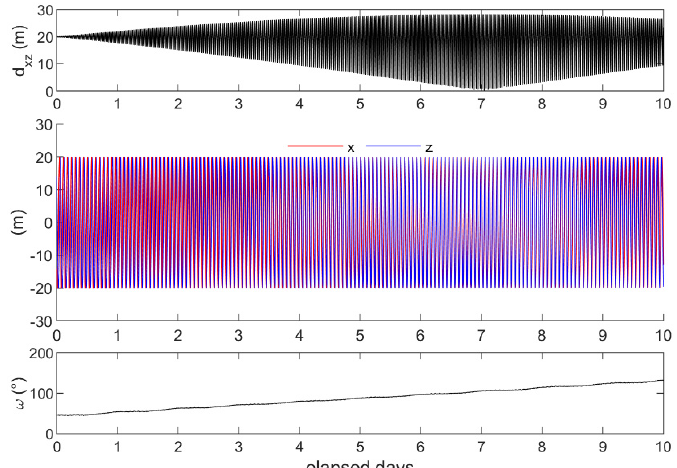
Figure 2. Two spacecraft formation based on safety tubes at low inclination: h = 550 km, d xz = A x = A z = 20 m. Evolution of d xz , x , z , and ω for the first ten days of mission.